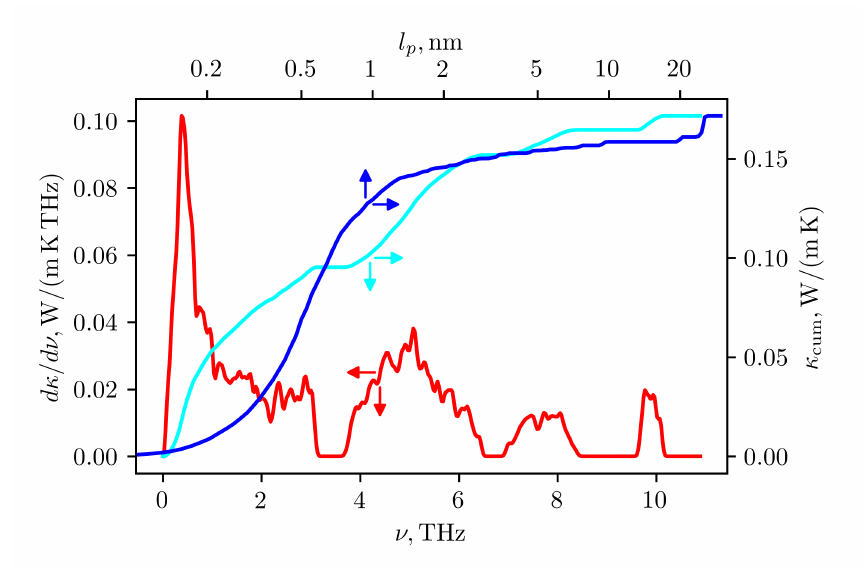
Figure 15. Spectral (red curve) and cumulative (cyan curve) contributions of phonons into lattice thermal conductivity at 300 K as a functions of phonon frequency. Blue curve shows cumulative thermal conductivity as a function of phonon mean free path l p . Arrows are directed to the axes used for plotting corresponding